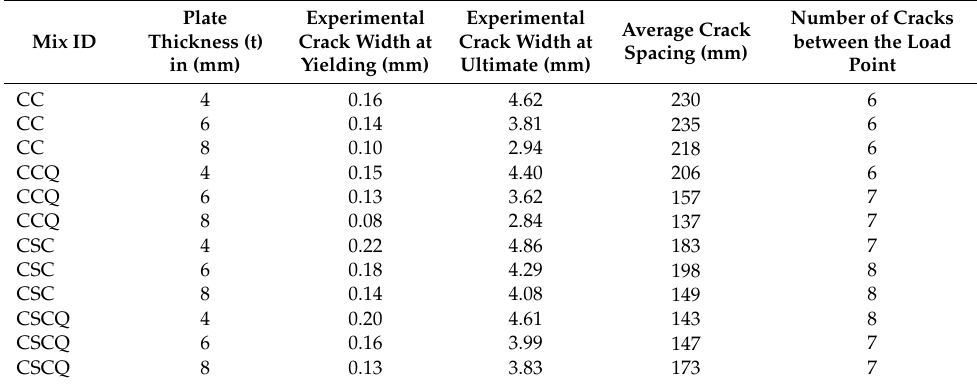
Table 7. Result of cracks formed details of the tested beams.